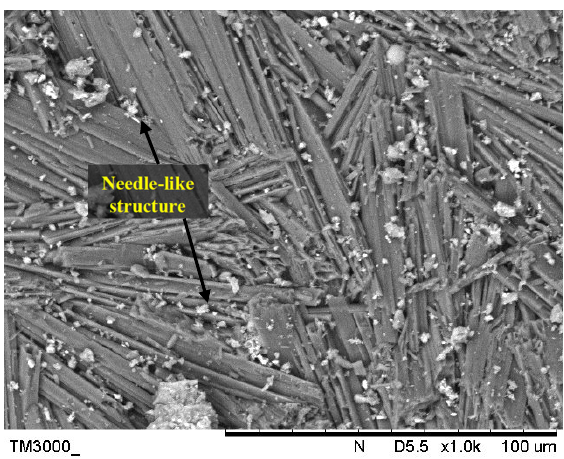
Figure 1. SEM images of metakaolin.